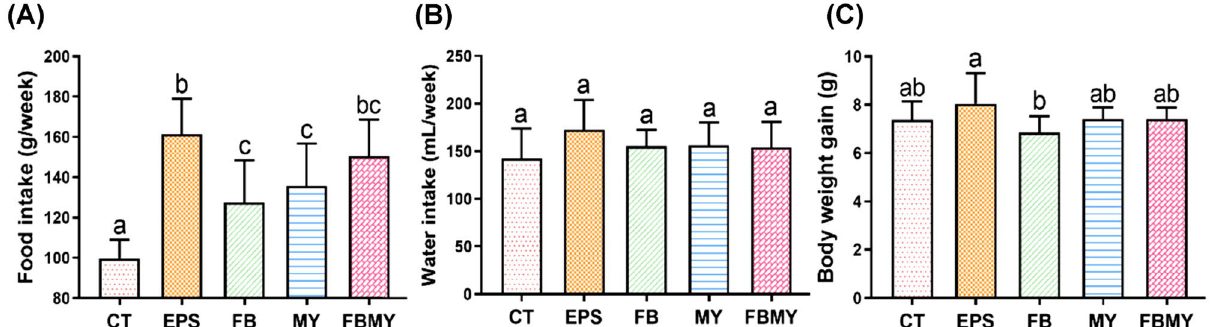
Figure 1. Effects of C. militaris fermentation products on food and water intake and body weight gain of JM mice during the 28-day experiment. Food intake (A) , water intake (B) , and body weight gain (C) were shown in different indicated groups. Values are presented as means ± SD (n = 5 for all test groups). Panels marked with different lowercase letters are significantly different ( p <